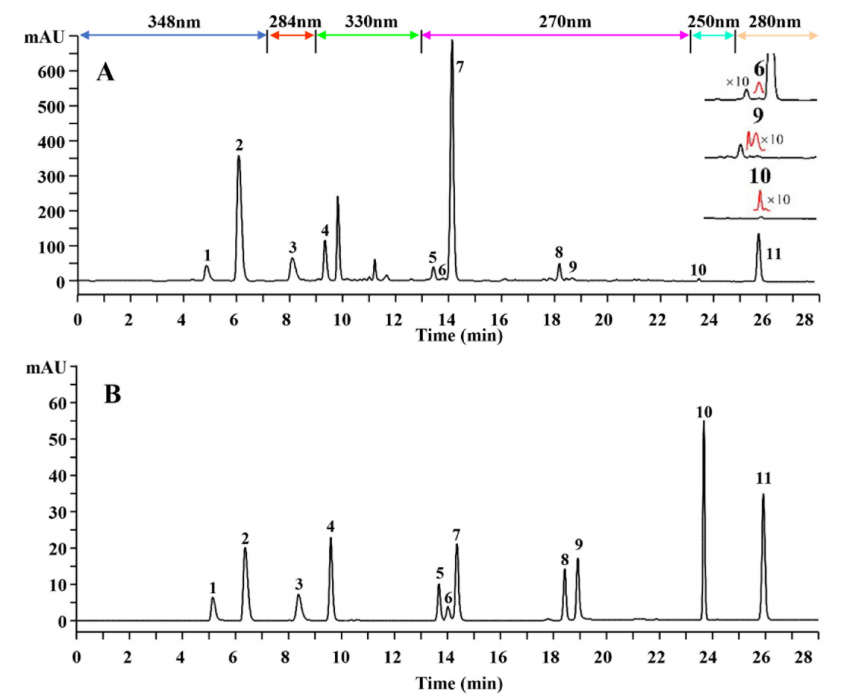
Figure 1. Chromatograms of ( A ) Clinopodium polycephalum sample and ( B ) mixed standard substances under segmental monitoring mode with HPLC-DAD. Standard substances representation: cynaroside ( 1 ), narirutin ( 2 ), apigenin-7-O- β -D-glucuronide ( 3 ), rosmarinic acid ( 4 ), buddleoside ( 5 ), luteolin ( 6 ), isosakuranetin-7-O-rutinoside ( 7 ), naringenin ( 8 ), apigenin ( 9 ), buddlejasaponin IVb ( 10 ) and isosakuranetin ( 11